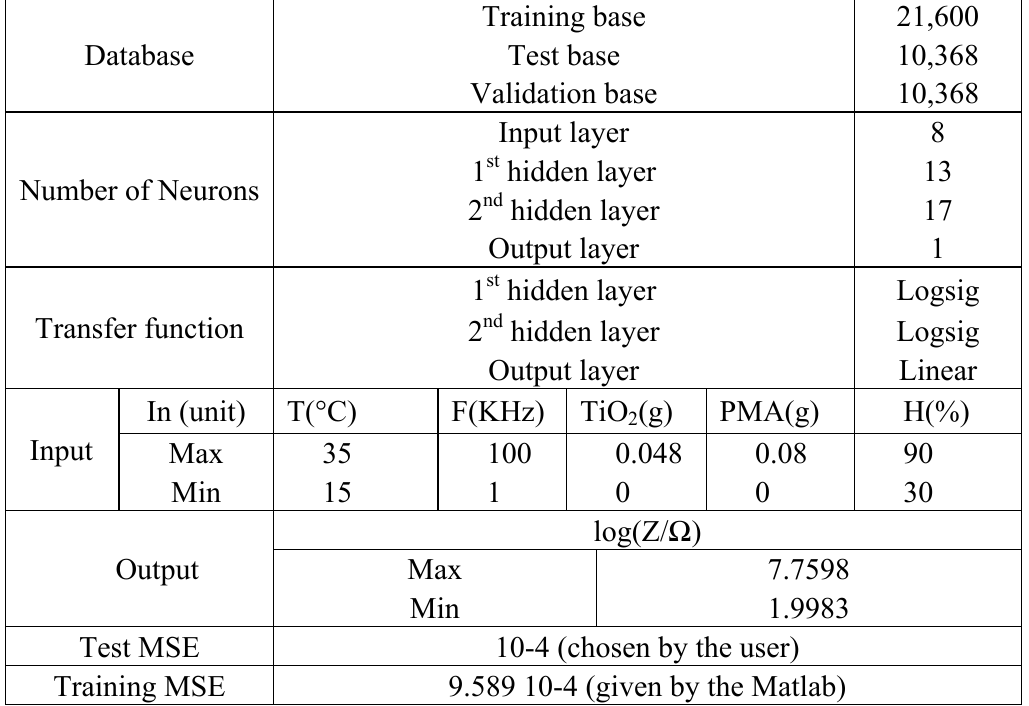
Table 2. Optimized parameters of the neural networks